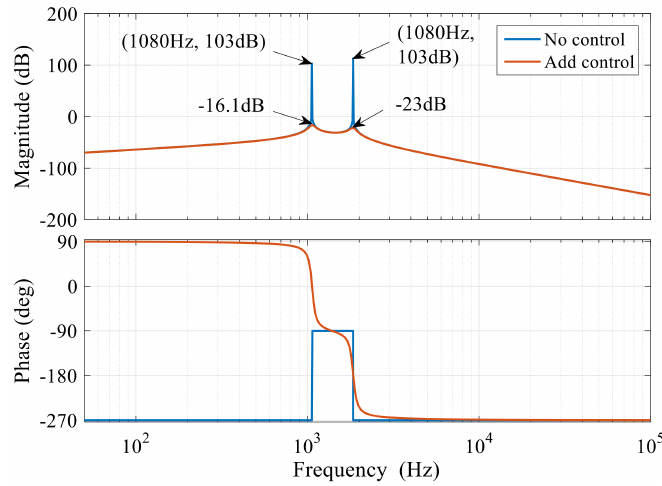
Figure 9. RC resonance suppression circuit frequency characteristic